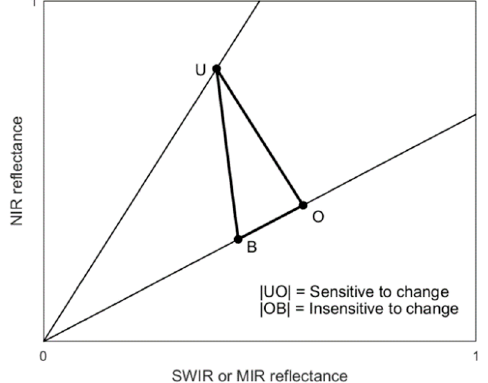
Figure 3. Example of pre- and post-fire trajectory of a pixel in the NIR–SWIR and NIR–MIR bi- spectral space. A pixel displaces from unburned ( U ) to burned ( B ). O resembles the position of an optimally sensed burned pixel. (NIR: near infrared, SWIR: short-wave infrared, MIR: mid